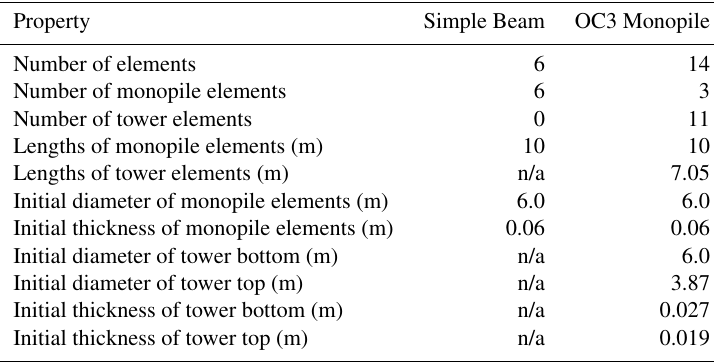
Table 1. Properties of the two models used in the study.